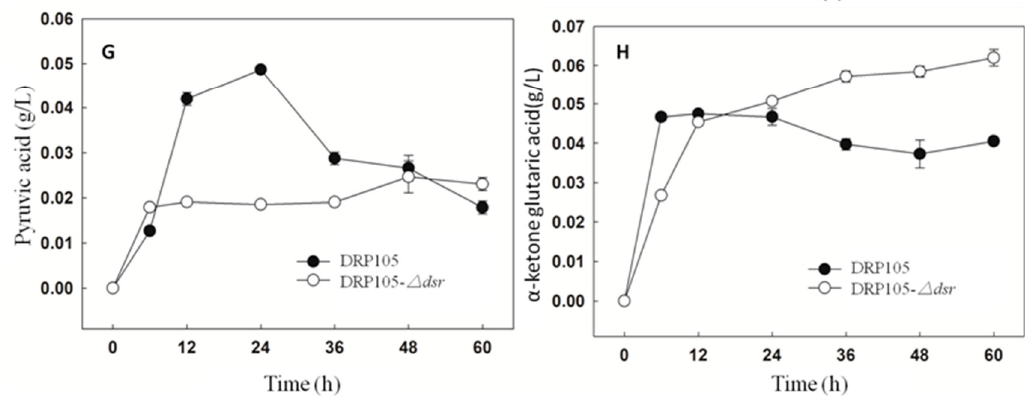
Figure 11. The organic acid content during Leu. mesenteroides DRP105 and Leu. mesenteroides DRP105 − ∆ dsr fermentation (( A ): lactic acid; ( B ): acetic acid; ( C ): formic acid; ( D ): malic acid; ( E ): citric acid; ( F ): succinic acid; ( G ): pyruvic acid; ( H ): α -ketone glutaric acid). The content of 21 free amino acids in the fermentation broth at 24 h is shown in Table 3. Total amino acids in the fermentation broth of Leu. mesenteroides DRP105 and Leu. mesenteroides DRP105 − ∆ dsr were 3329.7 ± 5.3 mg / kg and 3283.7 ± 3.8 mg / kg, respectively, with significant di ff erences ( p < 0.0001).